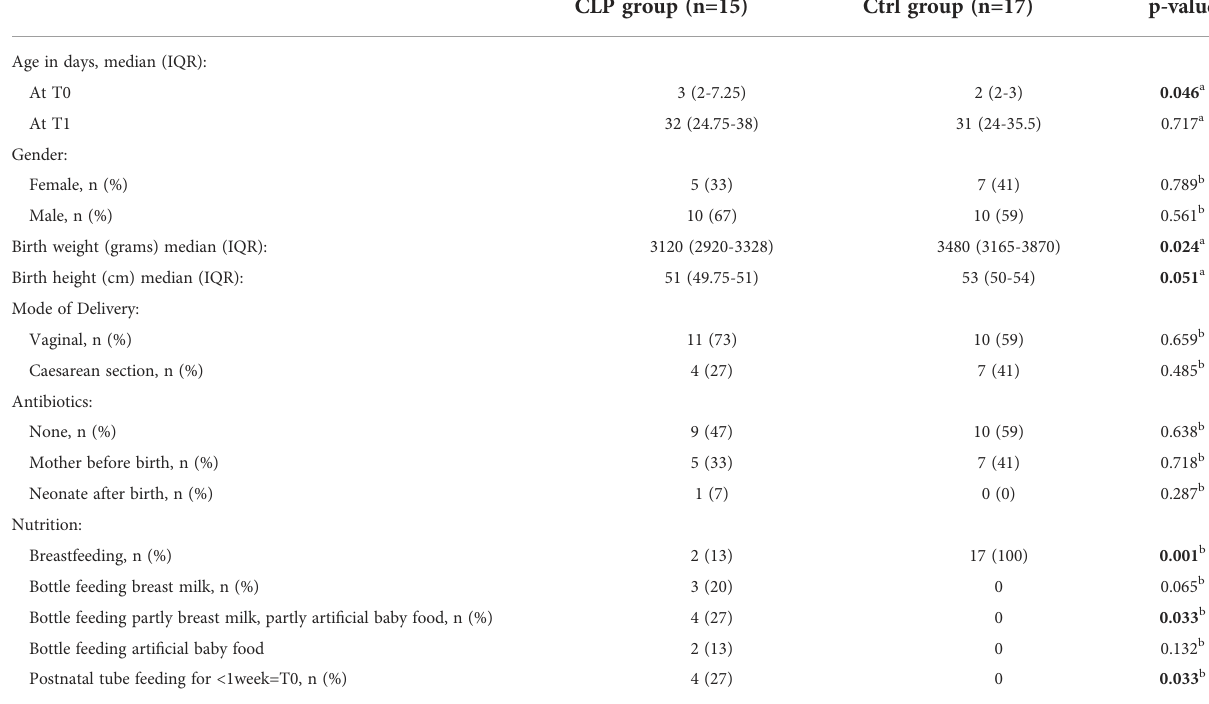
TABLE 3 Descriptive statistics and statistical comparisons between CLP group and Control